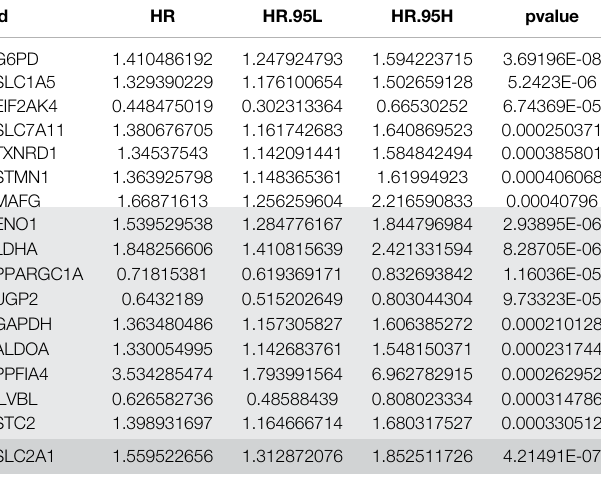
TABLE 3 | The seventeen ferroptosis-related genes and hypoxia-related